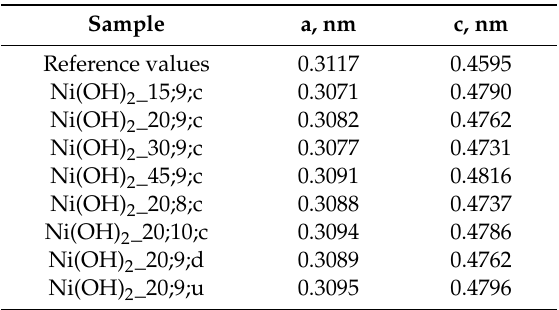
Table 2. Lattice periods of the nickel hydroxide samples.